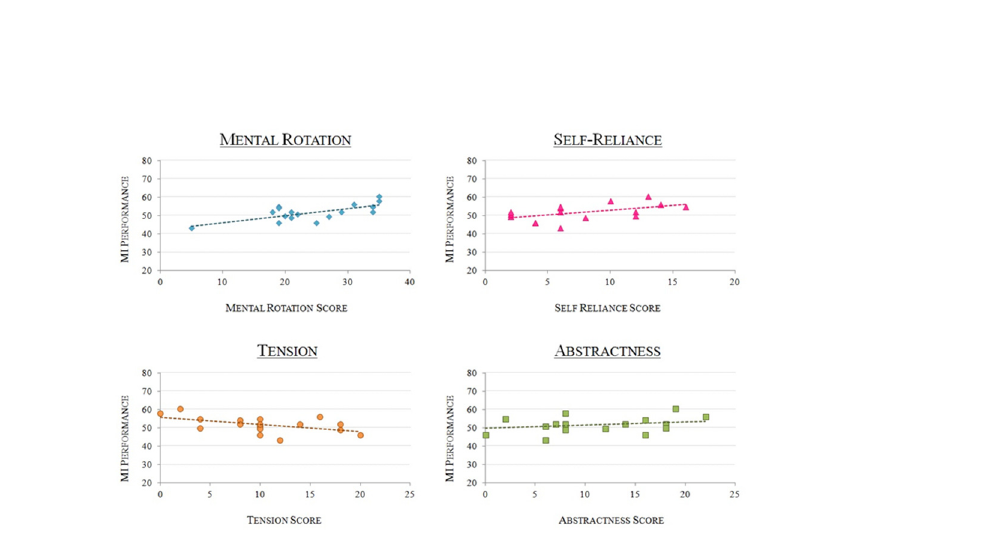
Fig 3. MI-BCI Performance as a function of personality profile. Graphs representing the participants ’ MI-BCI performances as a function of (1) Mental Rotation scores -top left-, r = 0.696; (2) Self-Reliance -top right-, r = 0.514; (3) Tension -bottom left-, r = -0.569; (4) Abstractness -bottom right-, r =